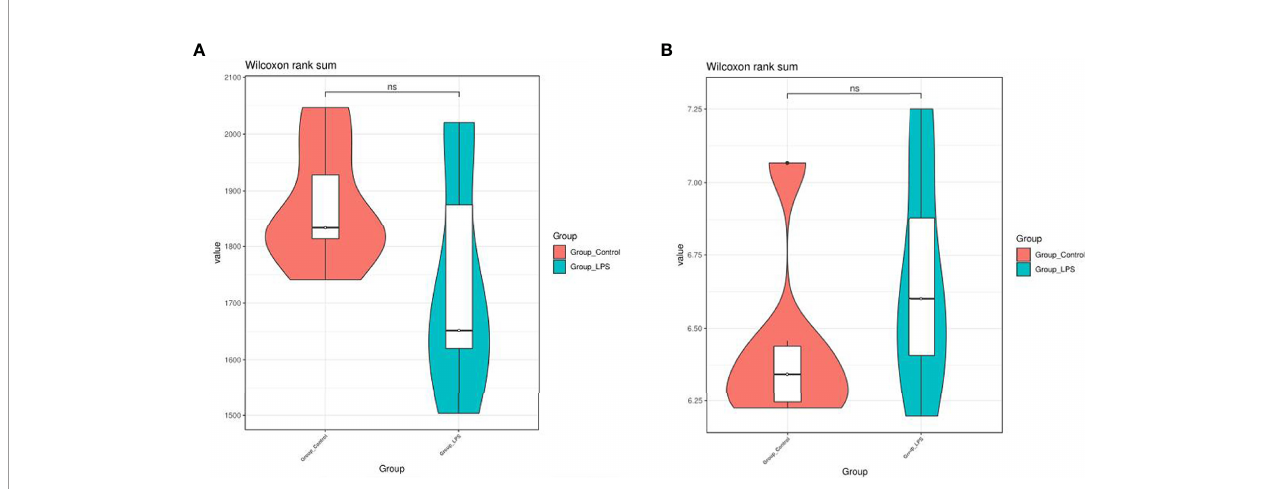
FIGURE 2 | Effects of LPS on the diversity and richness of intestinal microbiota in mice. (A) Chao1 index. (B) Shannon index. ns means no signi fi cant difference.